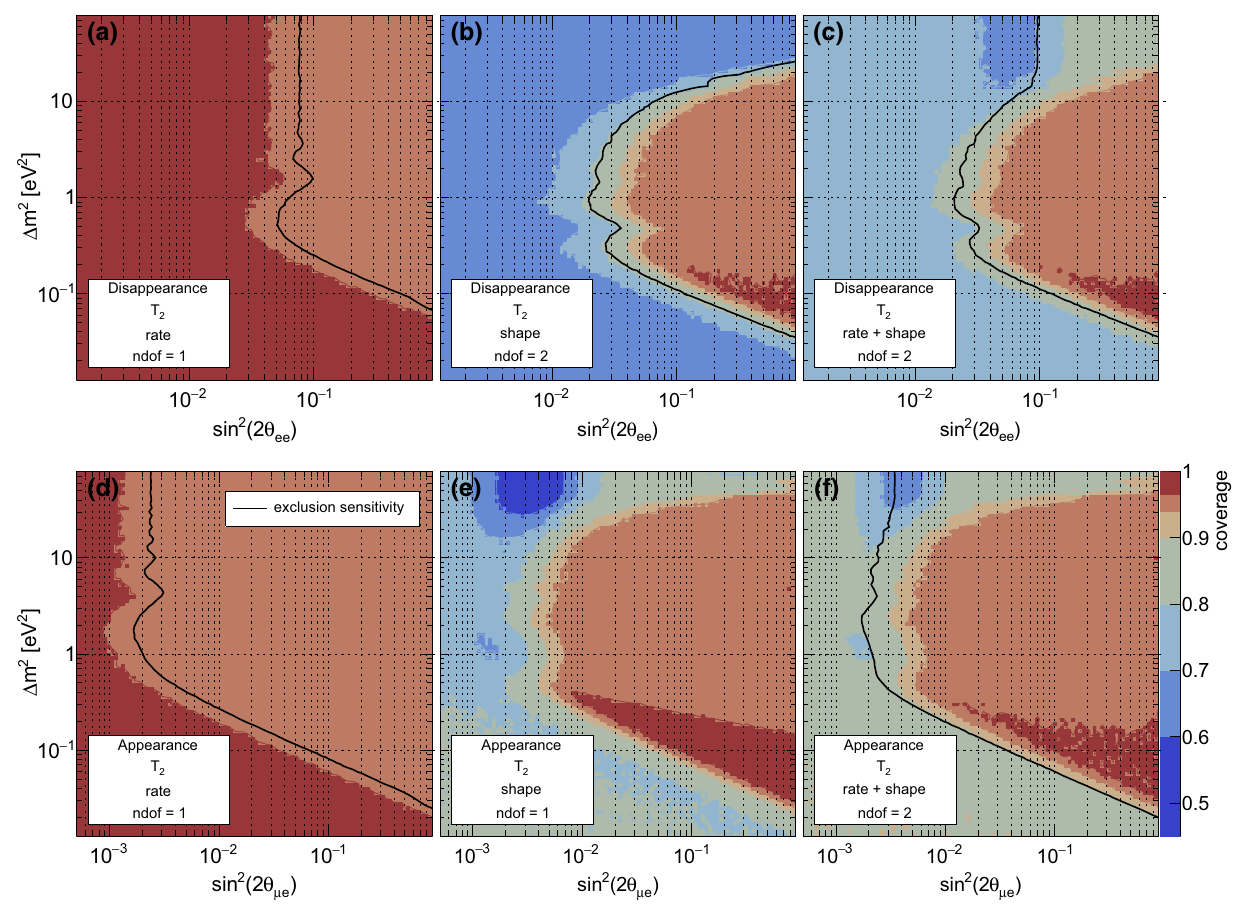
Fig. 5 Coverage of the 95%-CL confidence region based on the test performed with T 2 and assuming that this test statistic follows chi- squaredistributions.Thenumberofdegreesoffreedomofthechi-square distribution is two (i.e. the number of free parameters in the likelihood) unless these parameters are degenerate such as sin 2 ( 2 θ) and Δ m 2 in the rate analysis or sin 2 ( 2 θ) and N e in the shape analysis of the appear- ance experiment. The top panels show the coverage probability for the